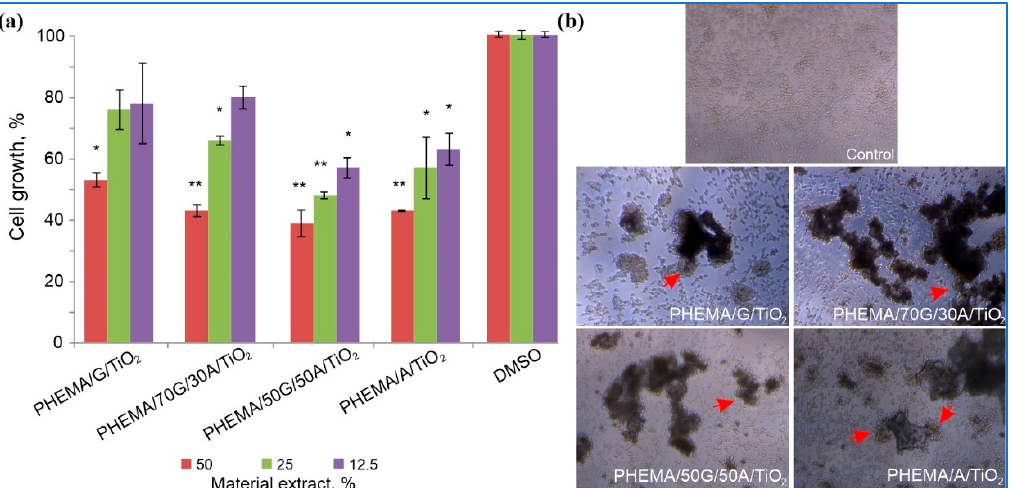
Figure 7. ( a ) Cell growth after 48 h of treatment with extracts of PHEMA/G/TiO 2 , PHEMA/70G/30A/TiO 2 , PHEMA/50G/50A/TiO 2 , and PHEMA/A/TiO 2 hybrid scaffolds (results are averages of n = 6, error bars represent standard deviation and percentage of alive cells was compared to the DMSO-treated control using a t -test; * p ≤ 0.05, ** p ≤ 0.01); ( b ) Cell growth in the presence of ground materials after 48 h (red arrowheads indicate accumulation of cells on the material surface). Images were taken under a microscope at 20× magnification.